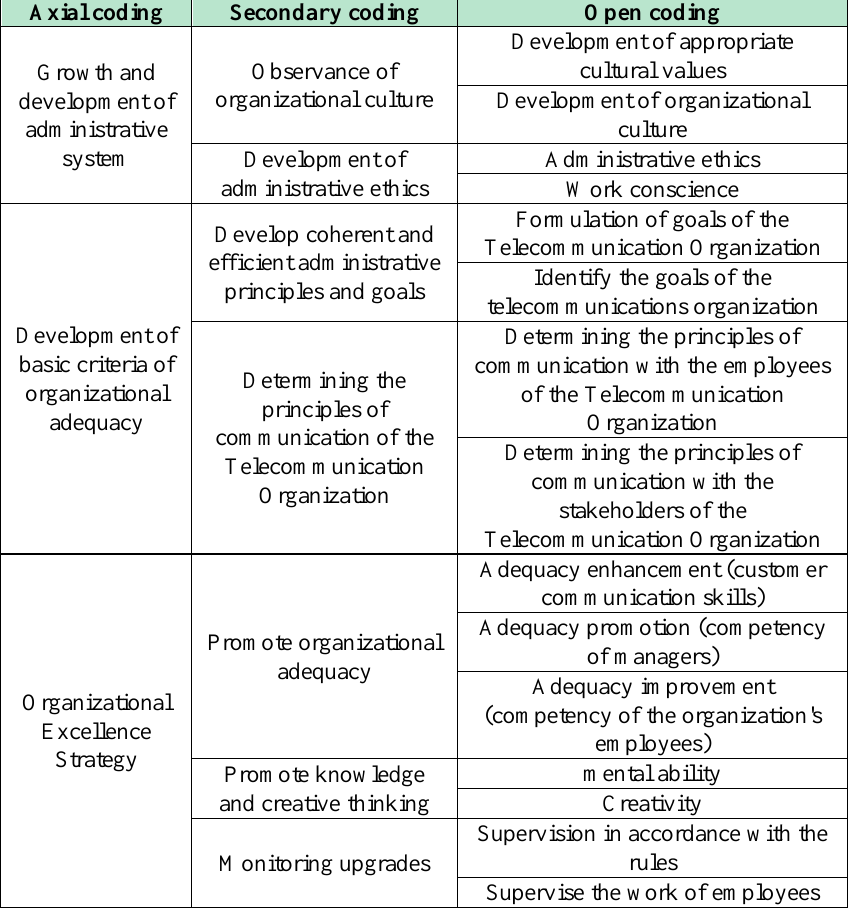
Table 4: Axial coding of qualitative data (strategic conditions) Axial